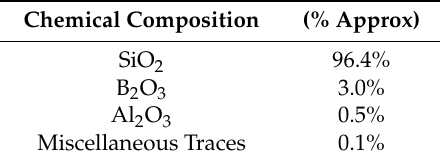
Table 2. Chemical composition of Vycor 7913 used for this study [15].